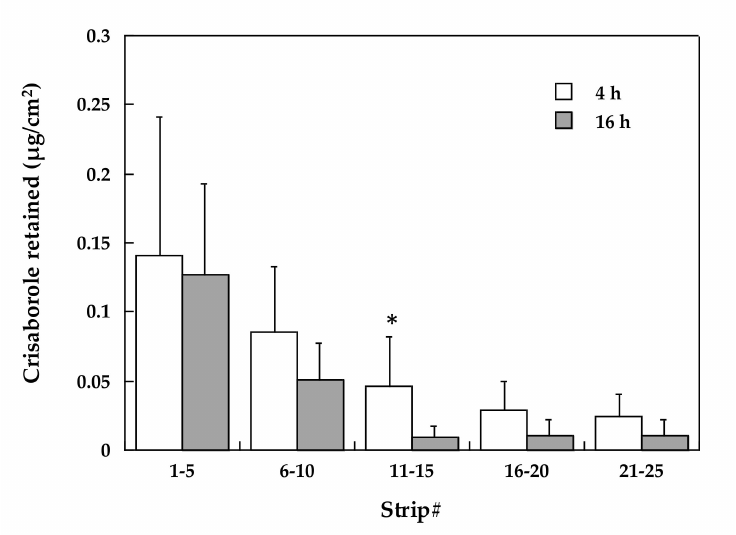
Figure 2. Recovery in the stratum corneum after application of the ointment for 4 ( white bars ) or 16 h ( grey bars ): Average values ± sd; * denotes statistical di ff erence ( p <